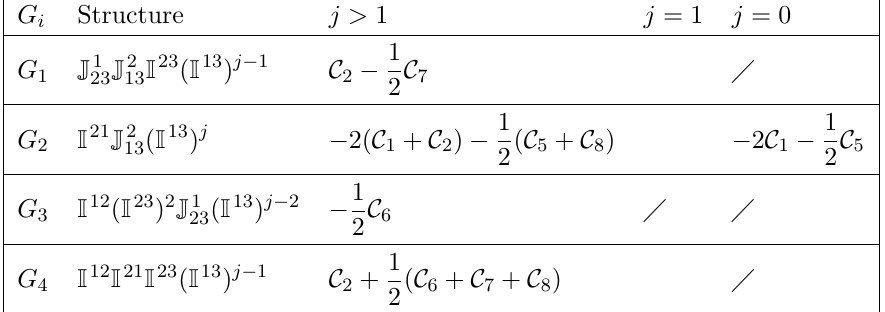
( QO ) SO when QO has h i = 0. C 6